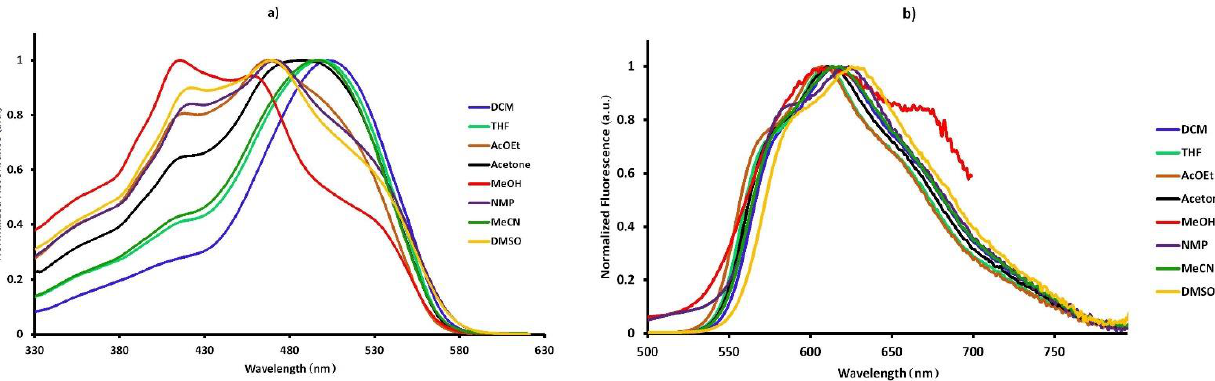
Figure 5. The normalized UV–Vis absorption of main bands ( a ) and fluorescence ( b ) spectra of 5–8 in DCM.